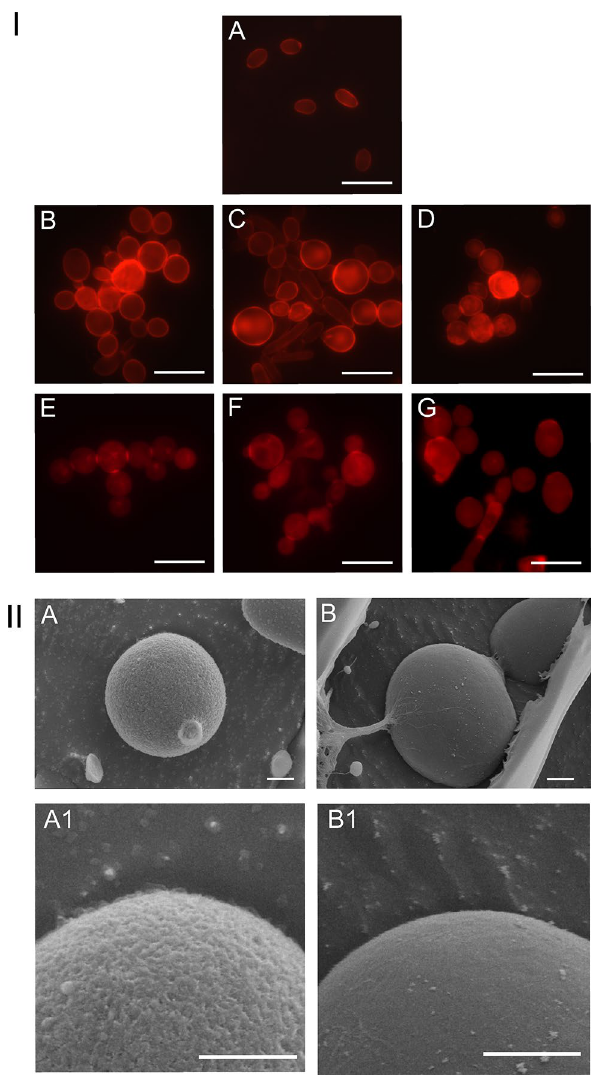
Figure 3. I. C. albicans cells after the incubation with Venetin-1 and fluconazole, stained with Congo red dye: ( A )—cells of the control culture; ( B )—cells after the incubation with Venetin-1 at 25 µg mL −1 ; ( C )—with Venetin-1 at 50 µg mL −1 ; ( D )—with Venetin-1 at 100 µg mL −1 ; ( E )—cells after the incubation with fluconazole at 5 µg mL −1 ; ( F )—with fluconazole at 10 µg mL −1 ; ( G )—with fluconazole at 20 µg mL −1 . The scale bar represents 10 µm. II. Cryo-SEM images of C. albicans cells; A–A1—cells of the control culture, B–B1—cells after the incubation with Venetin-1 at 100 µg mL -1 . The scale bar represents 1